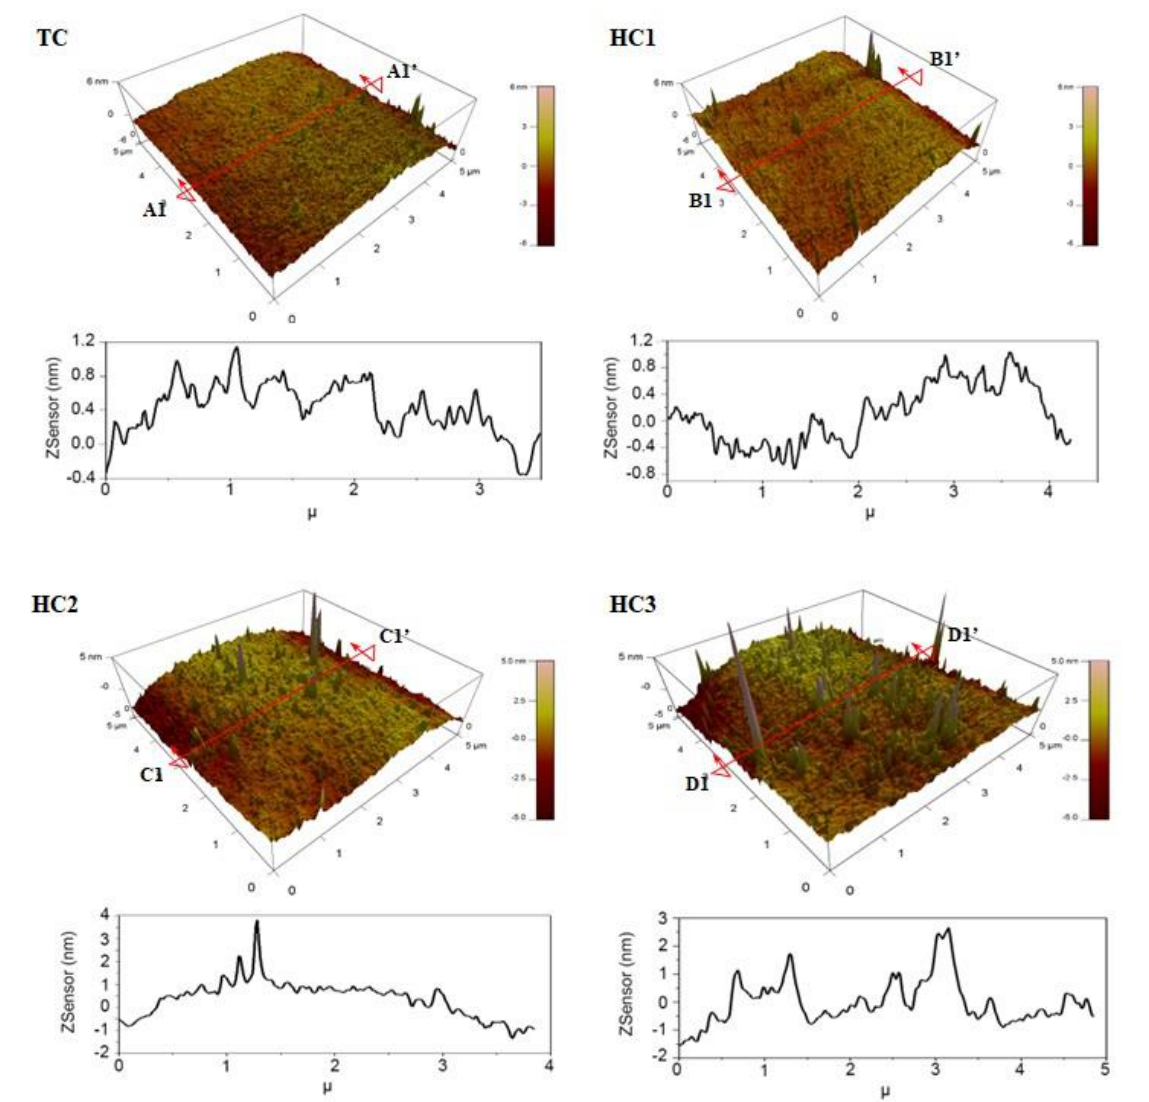
Figure 8. The tridimensional images of roughness by AFM, with an area of 5 µm × 5 µm in the surface of the TC, HC1, HC2, and HC3 coatings.